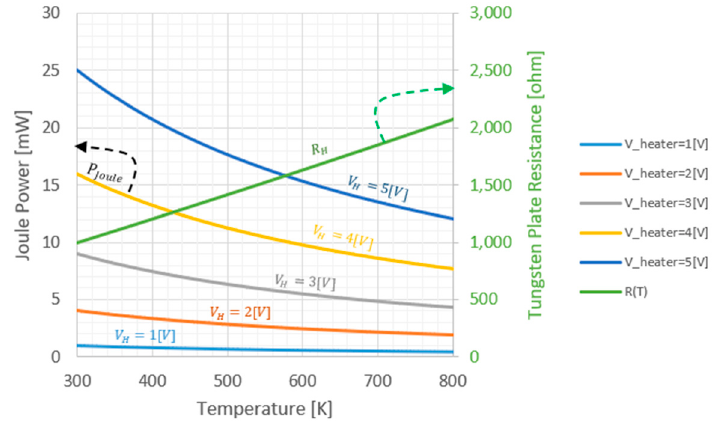
Figure 4. Joule power on tungsten heating resistor vs. temperature for R 0 = 1000 ohm.